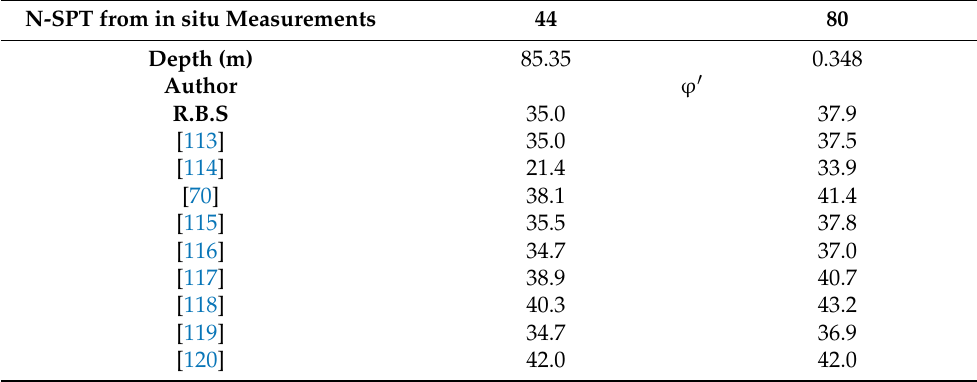
Table 5. ϕ (cid:48) values derived from the N-SPT value of the survey for each proposed author. N-SPT from in situ